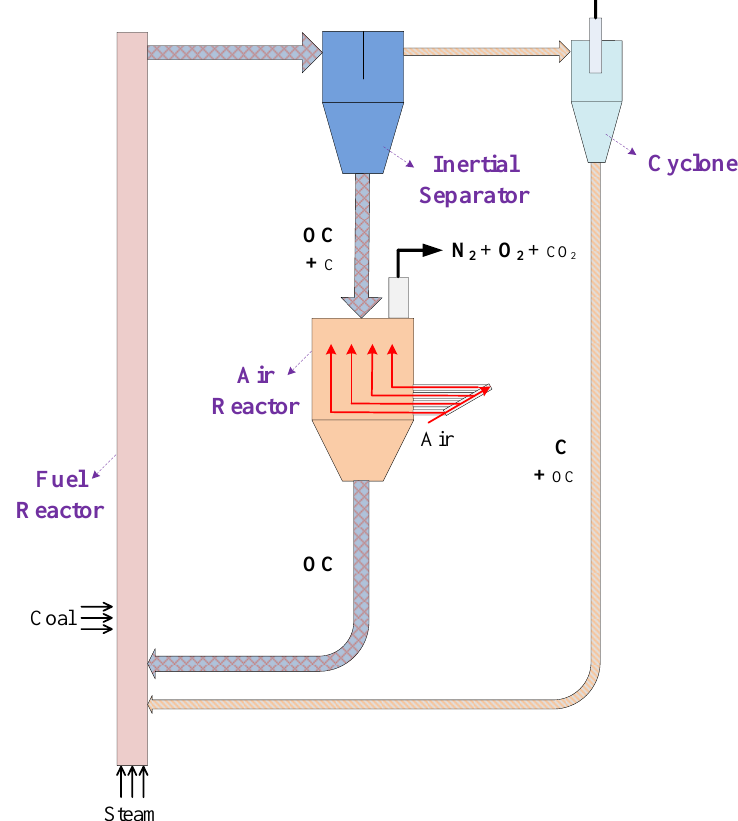
Figure 1. Schematic of the high-flux coal-direct chemical looping combustion (CDCLC) system (OC: oxygen carrier).